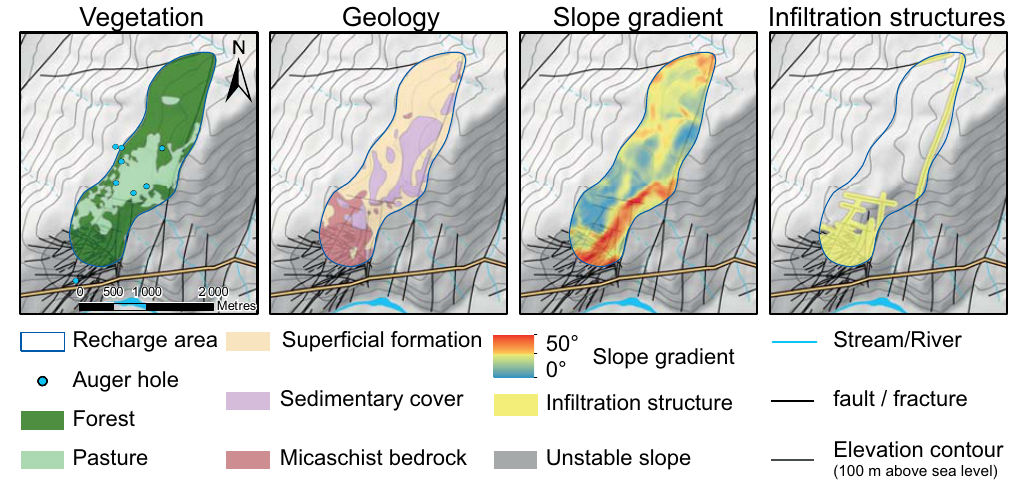
Figure 6. Factor subareas, auger holes and infiltration structures used for the estimation of recharge-area parameters.